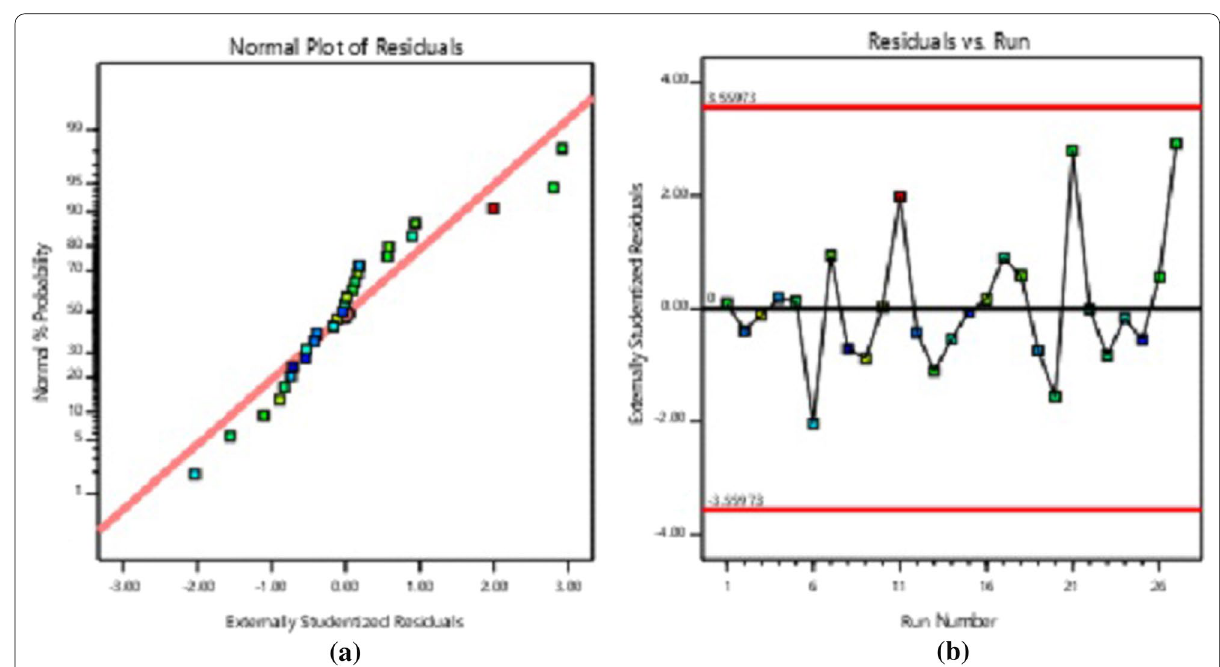
Fig. 8 Plot a between true and measured values with residual plot b for the response